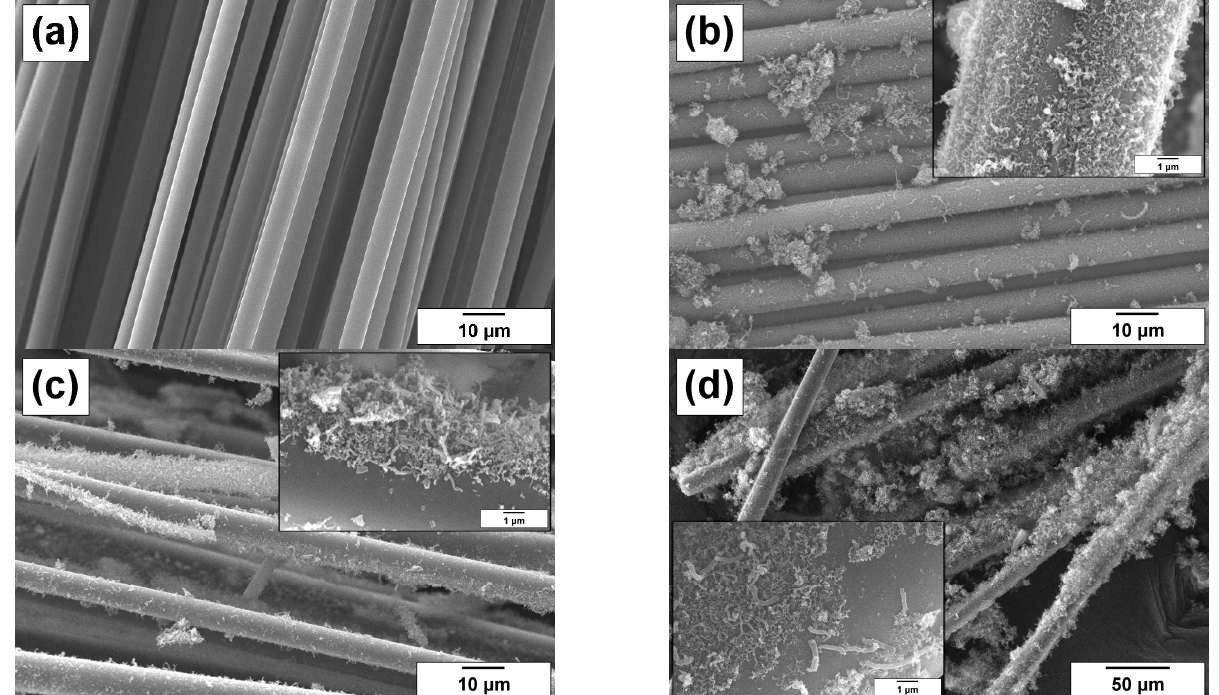
Figure 3. SEM images of the samples: ( a ) pristine carbon microfibers (CMF); ( b ) CNF/CMF (Y C = 40 wt%); ( c ) CNF/FGC (Y C = 36 wt%); ( d ) CNF/BMF (Y C = 50 wt%).